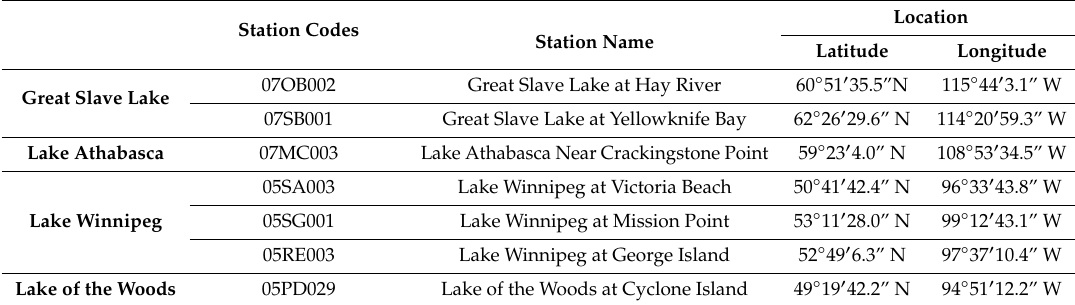
Table 2. Characteristics of hydrometric stations for the study